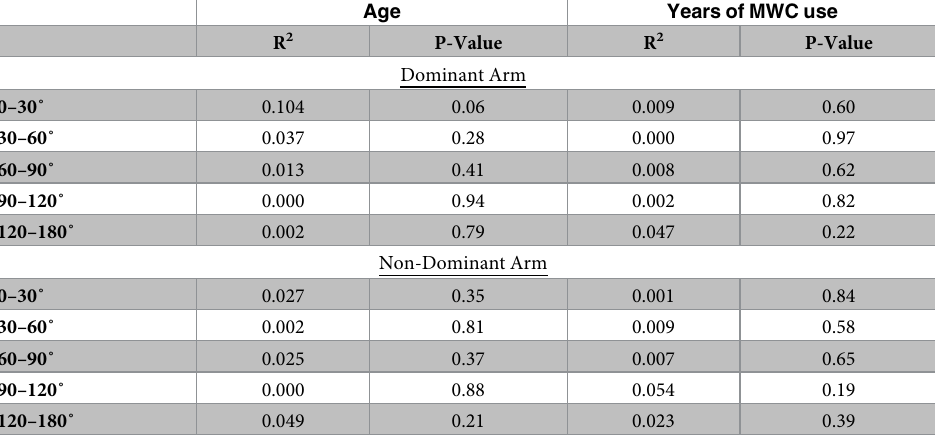
Table 4. Linear regression results for the percentage of time individuals spent in humeral elevation bins based on age and years of MWC use.